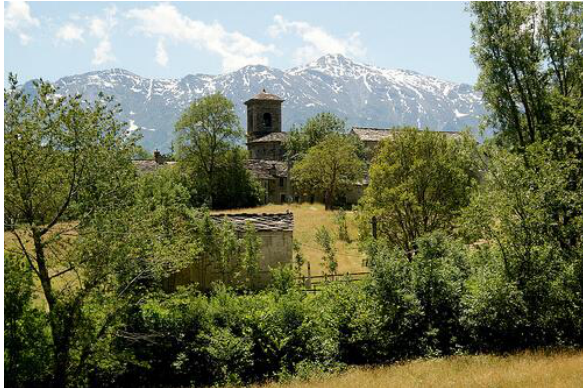
Figure 1 The complex of Novalesa Abbey (in the foreground,